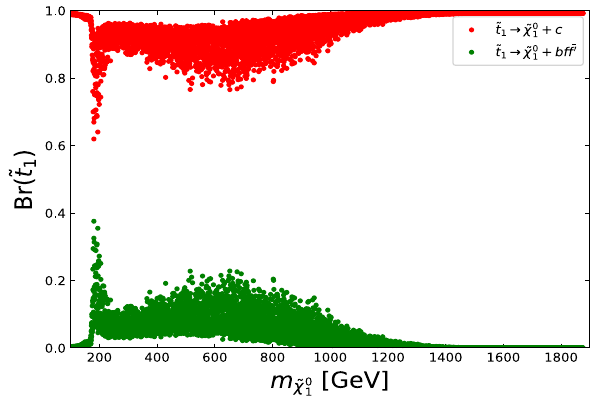
Fig. 6 The branching ratio of ˜ t 1 in the stop